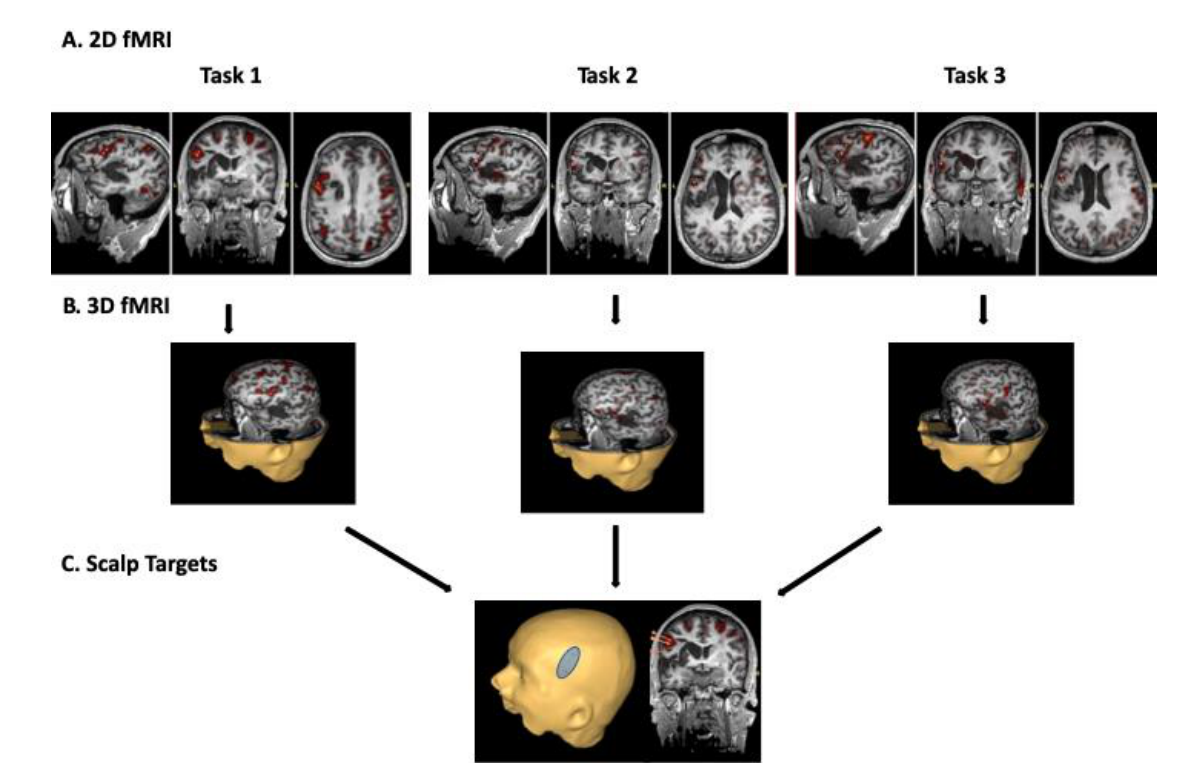
Figure 1. Individualized stimulation site was determined based on overlapping BOLD signals in the left hemisphere across three speech–language tasks. In each image, orange markers were placed using the neuronavigation system to identify locations of cortical activation. fMRI BOLD signals for each task were overlaid onto 2D images ( A ) and a 3D head reconstruction ( B ). While it is impossible to encompass all areas of activation, care was taken to locate stimulation sites with demonstrated activation in at least two of the three tasks. Lastly, scalp projections ( C ) of each stimulation site were generated and verified to fit underneath the surface area of the electrode. Table 1. Demographics, clinical characteristics, tDCS allocation, and stimulation site for study participants.